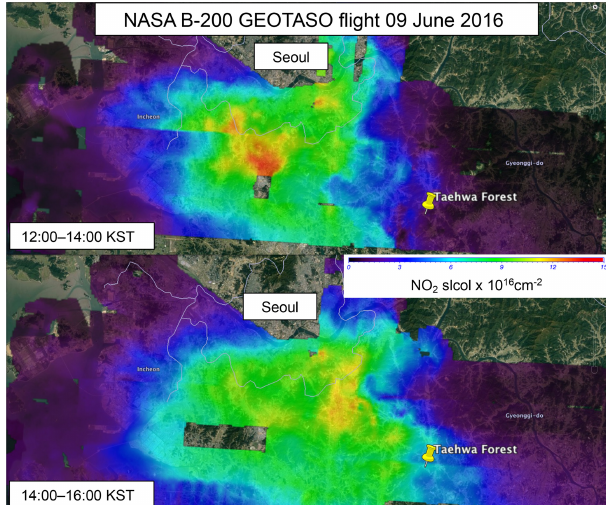
Figure 9. Observations of NO 2 slant columns from the GeoTASO instrument during the two afternoon science flights on 9 June 2016 from 12:00 to 14:00 and 14:00 to 16:00KST. TRF and Seoul are